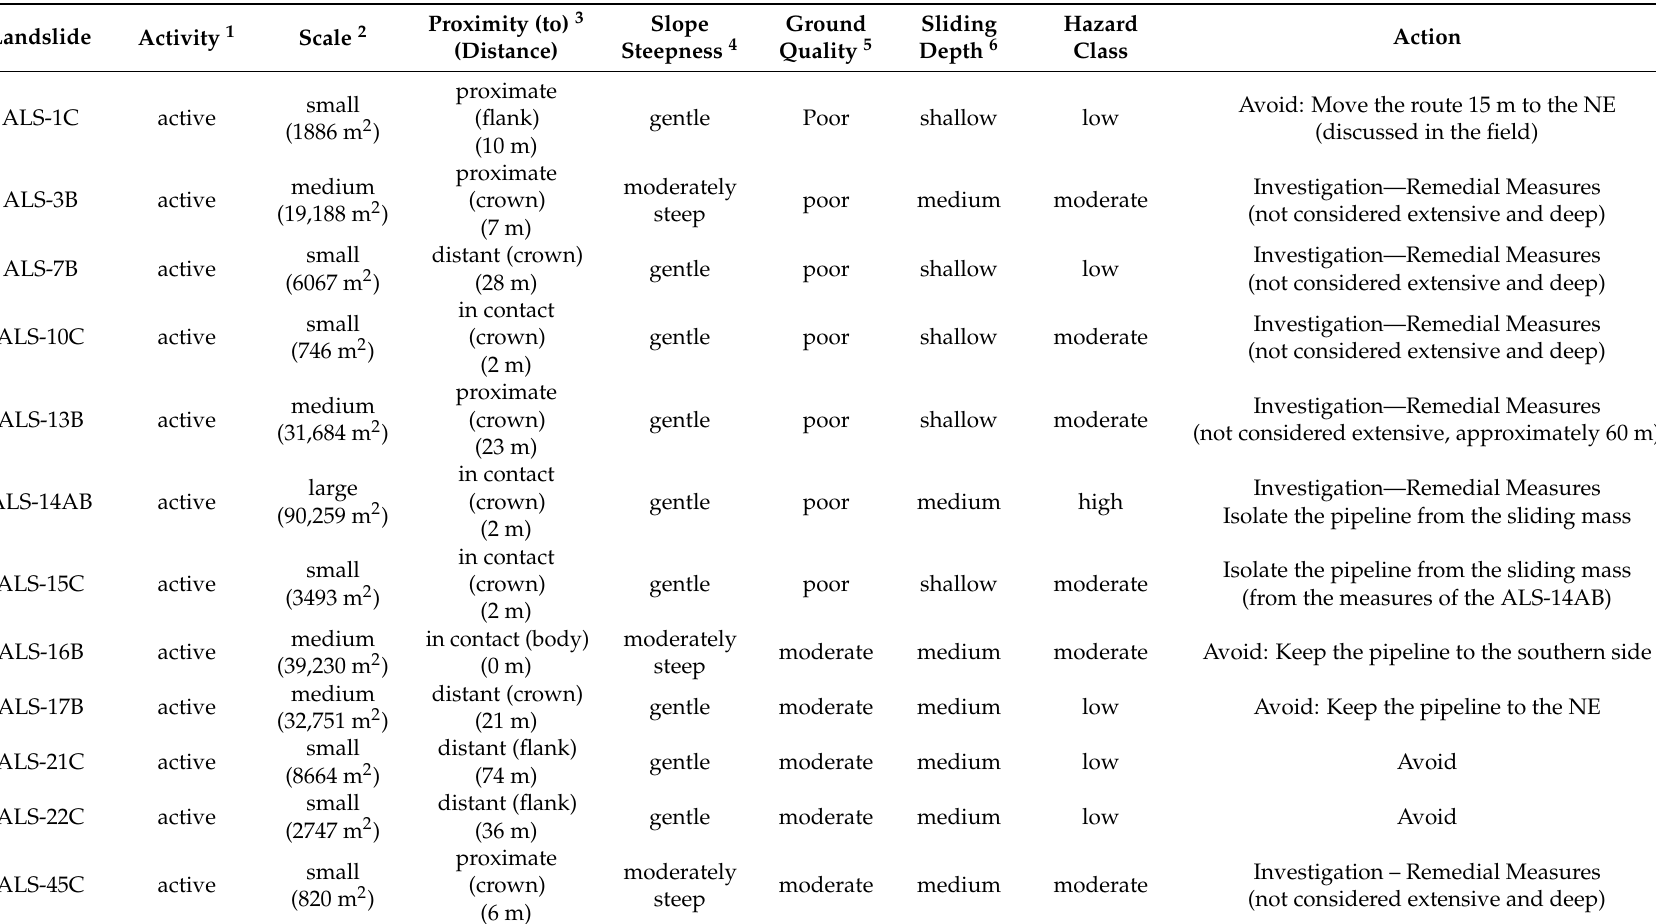
Table 1. Indicative landslide hazard assessment for some of the 82 identified landslides, including key assessment parameters and proposed actions (see Figures 12 and